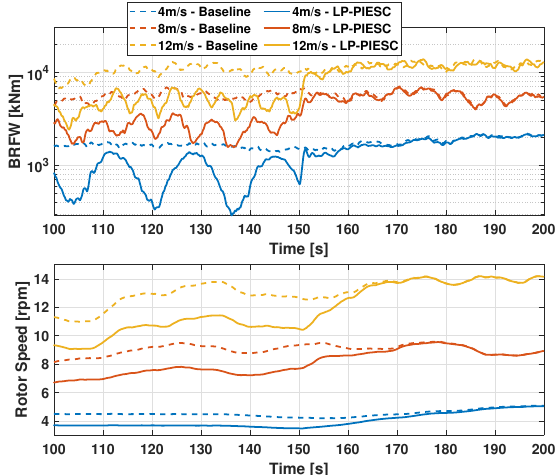
Figure 28. Effect of sudden change in blade pitch angle with LP-PIESC on blade-root flap-wise bending moment (BRFW) ( top ) and rotor speed ( bottom ) compared with the baseline (for hub height wind from Figure